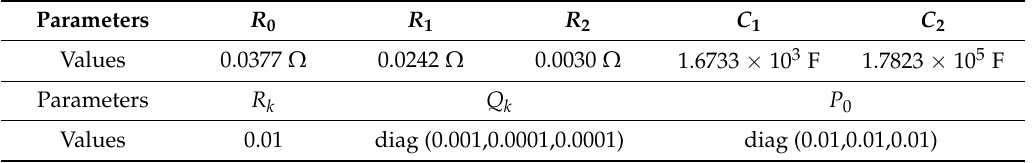
Table 2. Identified parameters and tuning parameters of the comparative EKF estimation method.